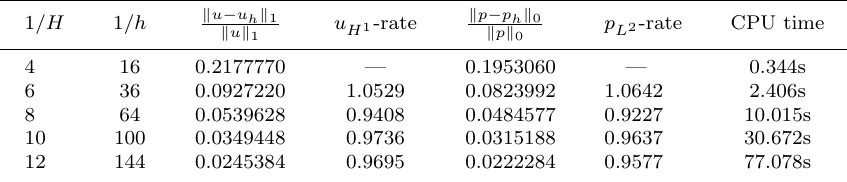
Table 7. Relative error and convergence rate of the two-grid method for the velocity and flux with τ 2 = h and ν =